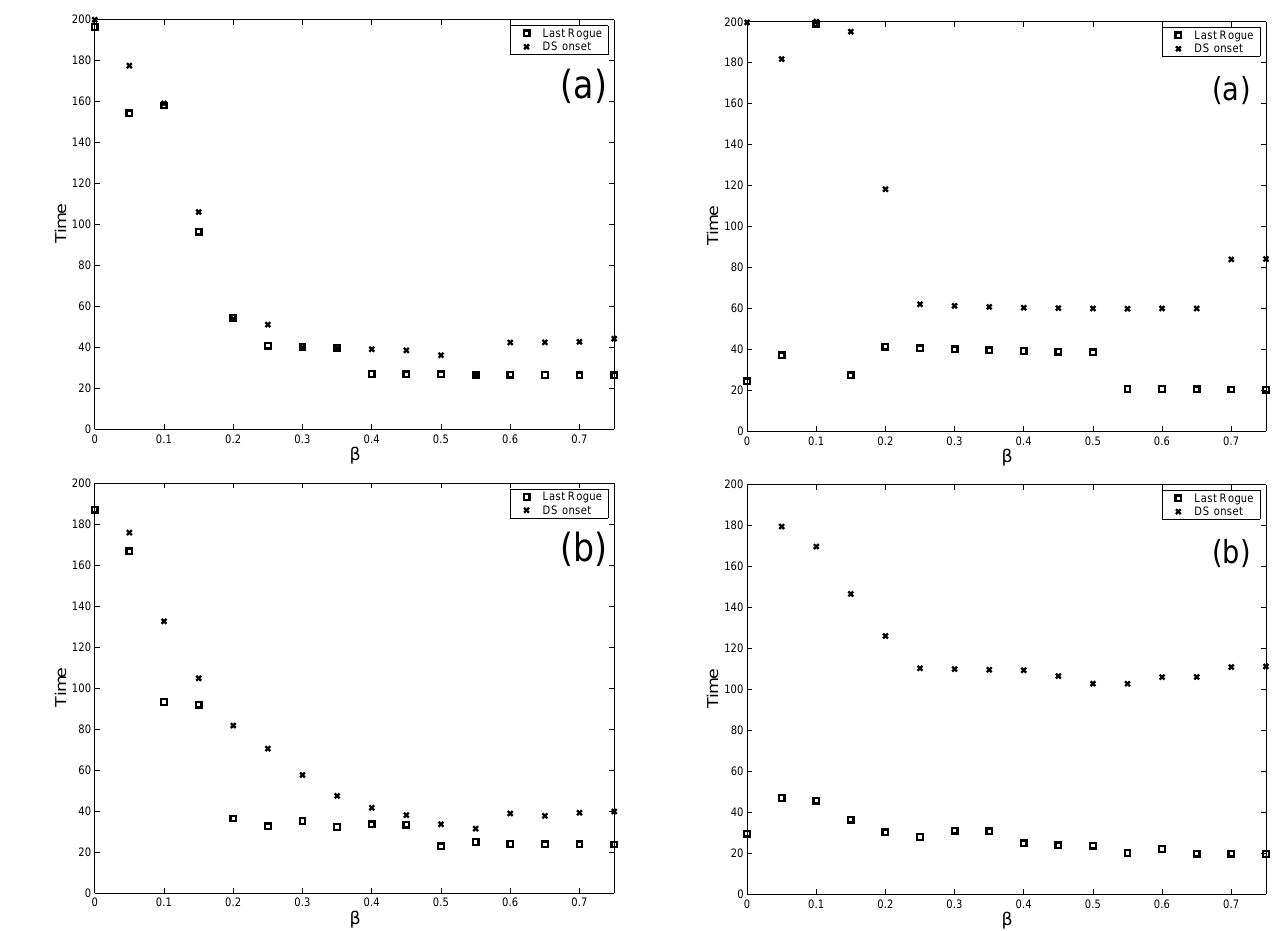
Fig. 15: The damped HONLS eqn. with ǫ = 0 . 05 , Γ = 0 . 005 Fig. 15. The damped HONLS eqn. with (cid:15) = 0 . 05, 0 = 0 . 005 and 0 <β < 0 . 75. The time downshifting is irreversible (x) and the time and 0 < β < 0 . 75 . The time downshifting is irreversible (x) and 0 < β < 0 . 75 . The time downshifting is irreversible (x) the last rogue wave occurs (box) as a function of β and 0 = 0 . 005, and the time the last rogue wave occurs (box) as a function of and the time the last rogue wave occurs (box) as a function of u 0 = a( 1 + 0 . 01cos µx) , where (a) a = 0 . 63 and (b) averaged over β and Γ = 0 . 005 , u 0 = a (1+0 . 01cos µx ) , where (a) a = 0 . 63 β and Γ = 0 . 005 , u 0 = a (1+0 . 01cos µx ) , where (a) a = 0 . 63 0 . 57 <a < 0 . and (b) averaged over 0 . 57 < a < 0 . 67 . and (b) averaged over 0 . 57 < a < 0 . 67 .